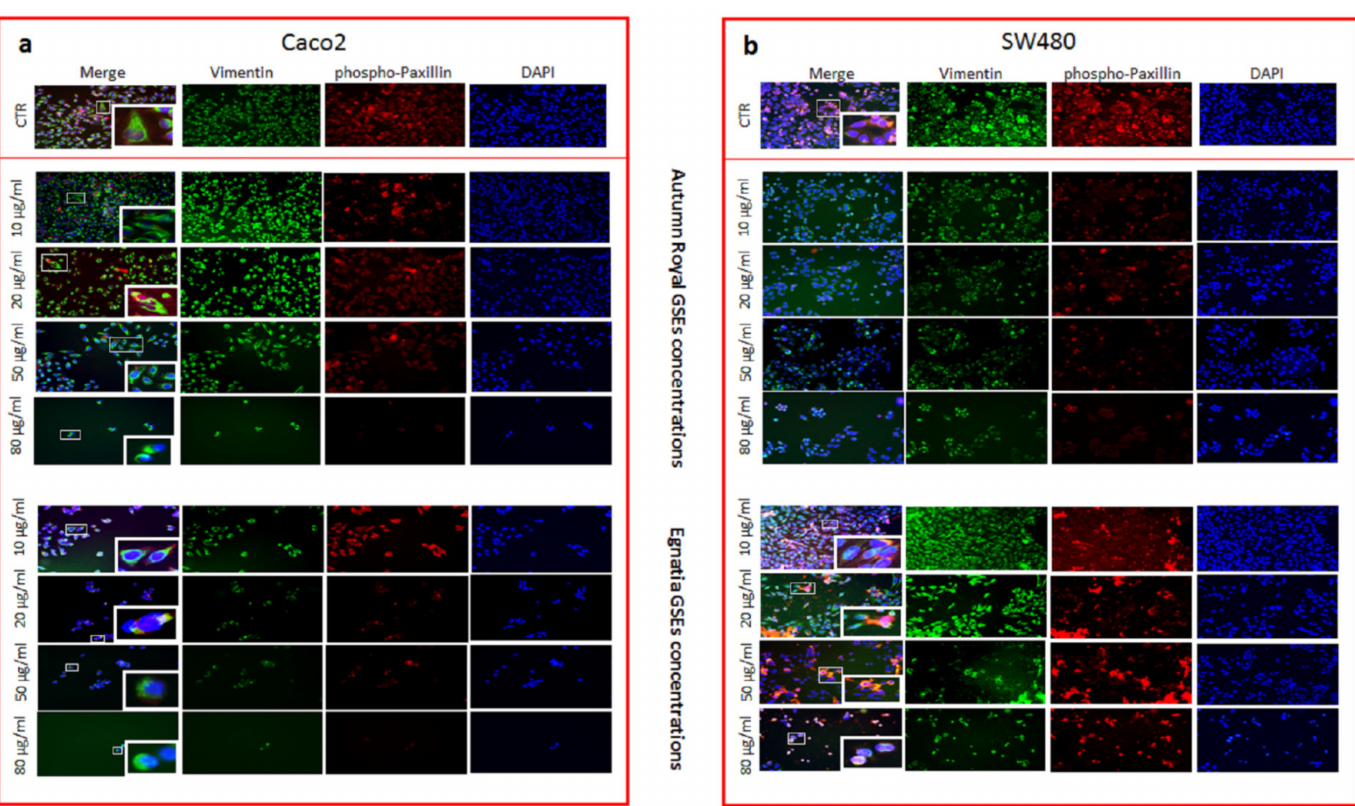
Figure 6. ( a ) Detection of Vimentin and phospho-Paxillin with a 40 × objective immunofluorescence confocal microscopy in fixed Caco2 cell lines treated with increasing concentrations of Autumn Royal and Egnatia GSEs (10, 20, 50, and 80 µ g / mL) for 48 h; ( b ) Detection of Vimentin and phospho-Paxillin with a 40 × objective immunofluorescence confocal microscopy in fixed SW480 cell lines treated with increasing concentrations of Autumn Royal and Egnatia GSEs (10, 20, 50, and 80 µ g / mL) for 48 h. Untreated cells were used as control (CTR). Green channel: labeled Vimentin, red channel: labeled phospho-Paxillin, blue channel: labeled nuclei (DAPI), and corresponding overlay (Merge). The images were randomly taken using five di ff erent areas from the single well. The enlarged squares indicate the areas of cells to which it refers in the